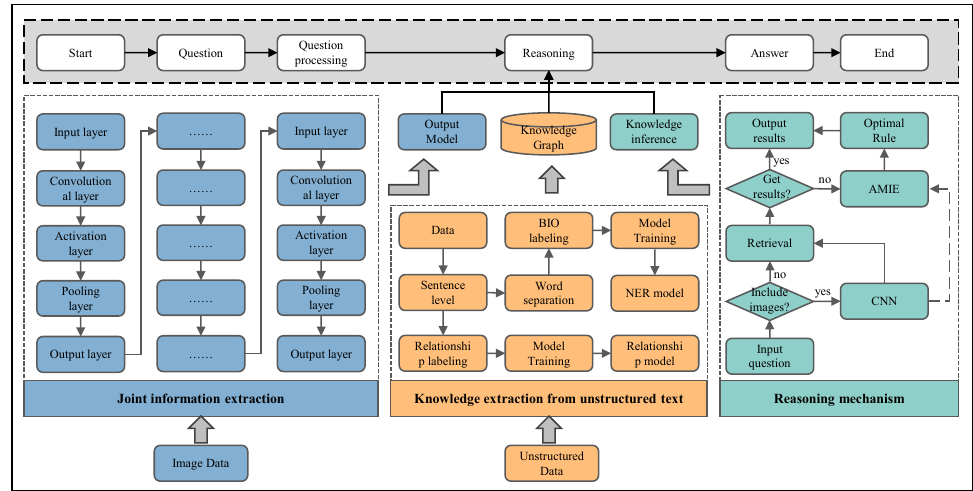
Figure 3. Overall process. The knowledge graph was built based on CNN, NER, and relationship extraction models. The fusing of AMIE and CNN is used to acquire knowledge related to engineering problems.